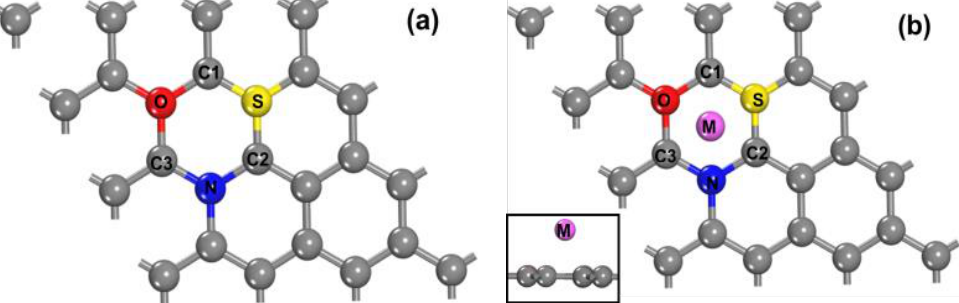
Figure 1. The top view of density functional theory (DFT) simulation modes ( a ) N, S co-doped graphene quantum dots (N, S-GQDs), ( b ) M cations (M = Fe 3+ , Hg 2+ ) adsorb on the surface of N, S-GQDs. Table 1. The atomic populations of pure graphene and N, S-GQDs.